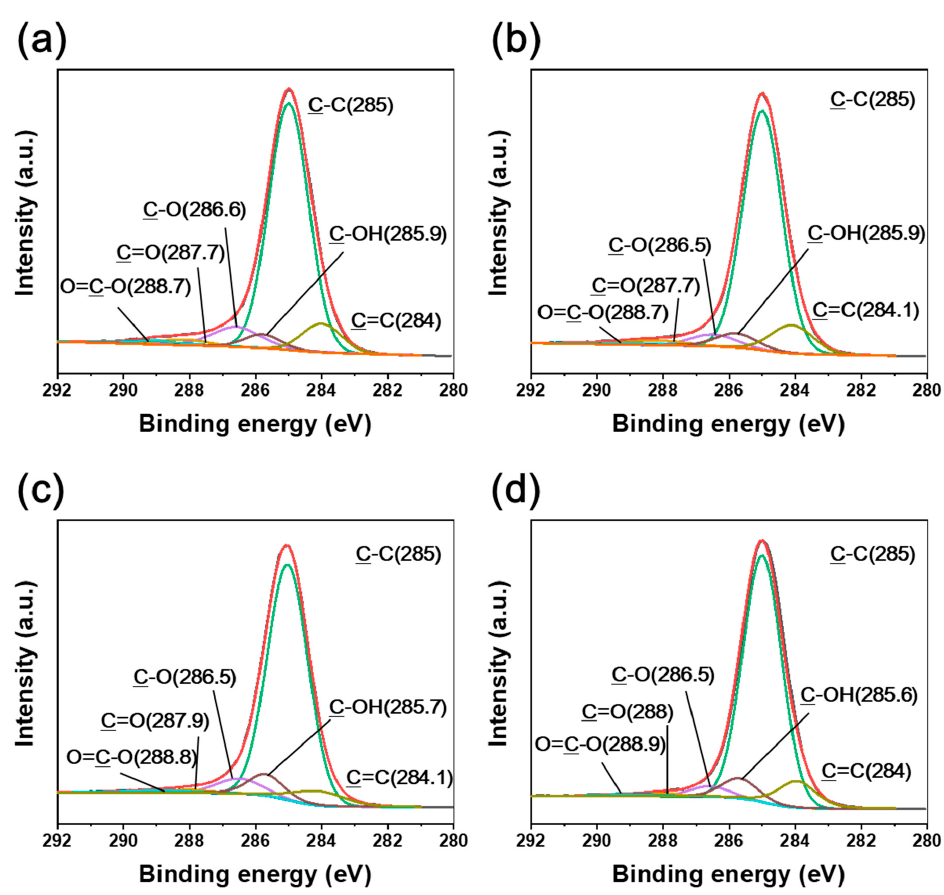
Figure 4. C1s XPS spectra of CFRTPs irradiated at ( a ) 3.4 kGy/s, ( b ) 6.8 kGy/s, ( c ) 13.5 kGy/s, and ( d